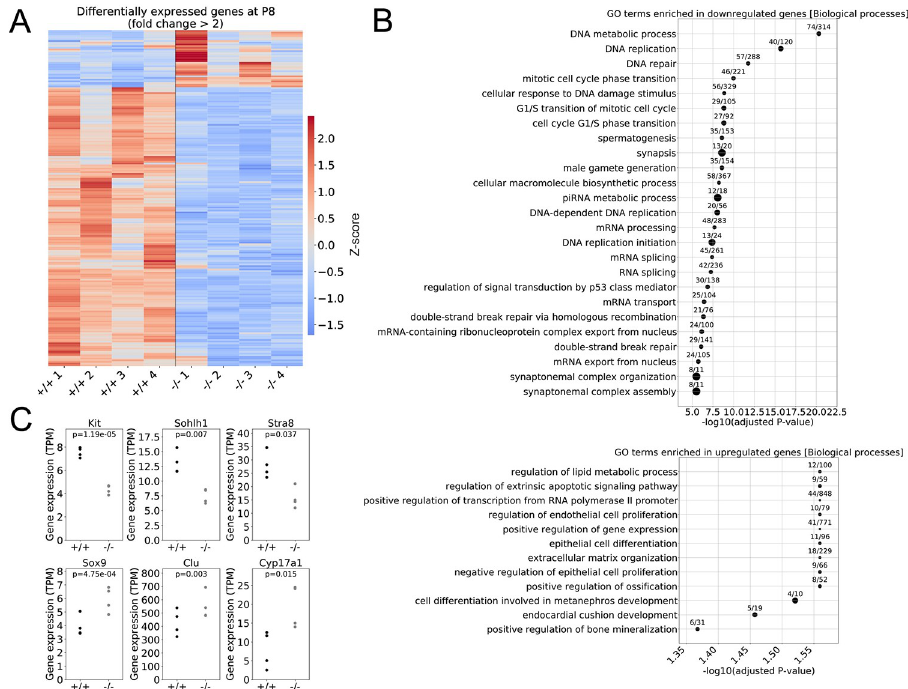
Fig 5. Genes involved in cell cycle regulation were deregulated in Rbm46 -/- testes at P8. ( A ) Heatmap of 200 genes with > 2-fold changes in Rbm46 -/- relative to Rbm46 +/+ controls at P8. ( B ) Gene ontology terms for biological processes enriched in genes that are downregulated (top) or upregulated (bottom) in Rbm46 -/- . Circle size and numbers correspond to the number of genes that are differentially expressed and represented in a GO term over to the total number of genes listed in the GO term. ( C ) Expression level of genes involved in spermatogonia differentiation and somatic cell markers. P-values are DESeq2 adjusted p-values comparing Rbm46 +/+ to Rbm46 -/-